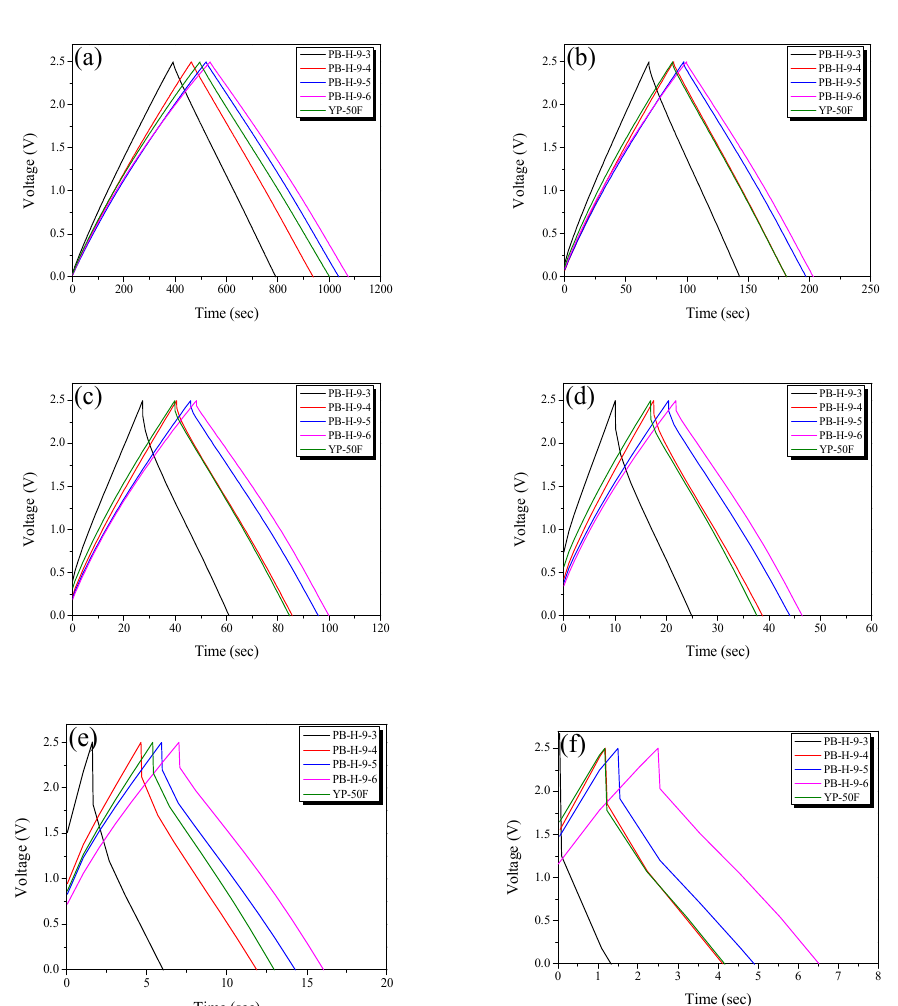
9 of 16 resistance as the current density increased. Further, the IR drops measured for the differ- ent electrodes decreased as the activation time increased, and that of PB-H-9-6 was the